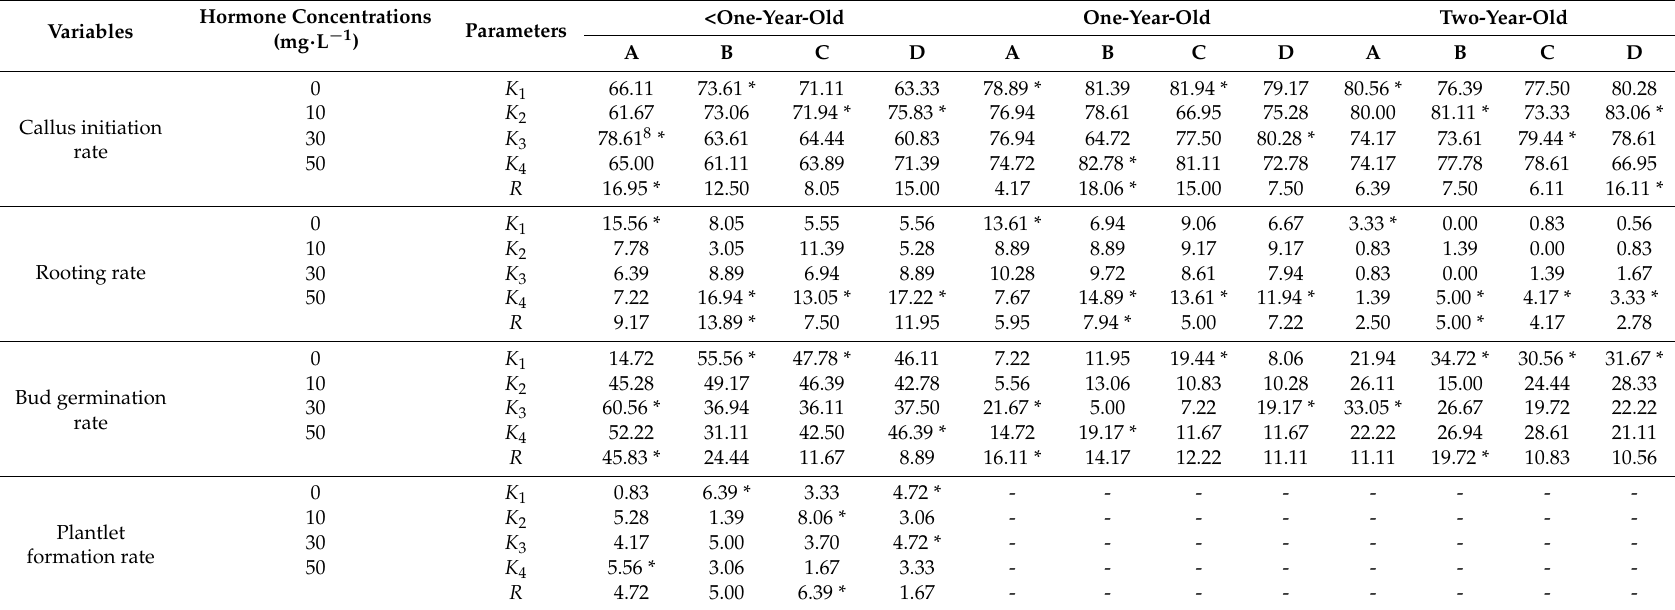
Table 3. Range analysis of results from the L 16 (4) 4 orthogonal experiment examining the callus initiation rate, rooting rate, bud germination rate, and plantlet formation rate. * represented the optimal level in each